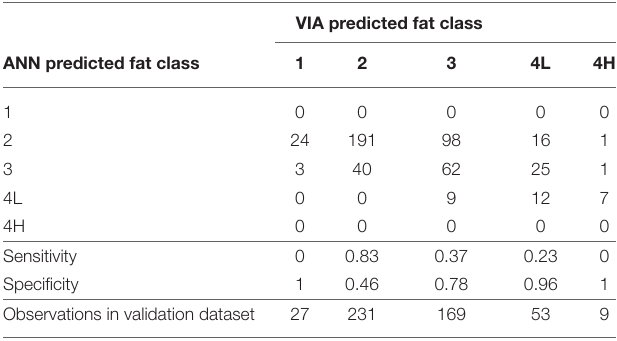
TABLE 4 | Confusion matrix for the fat grade classification artificial neural network and the sensitivity and specificity of the model to each grade. VIA predicted fat class